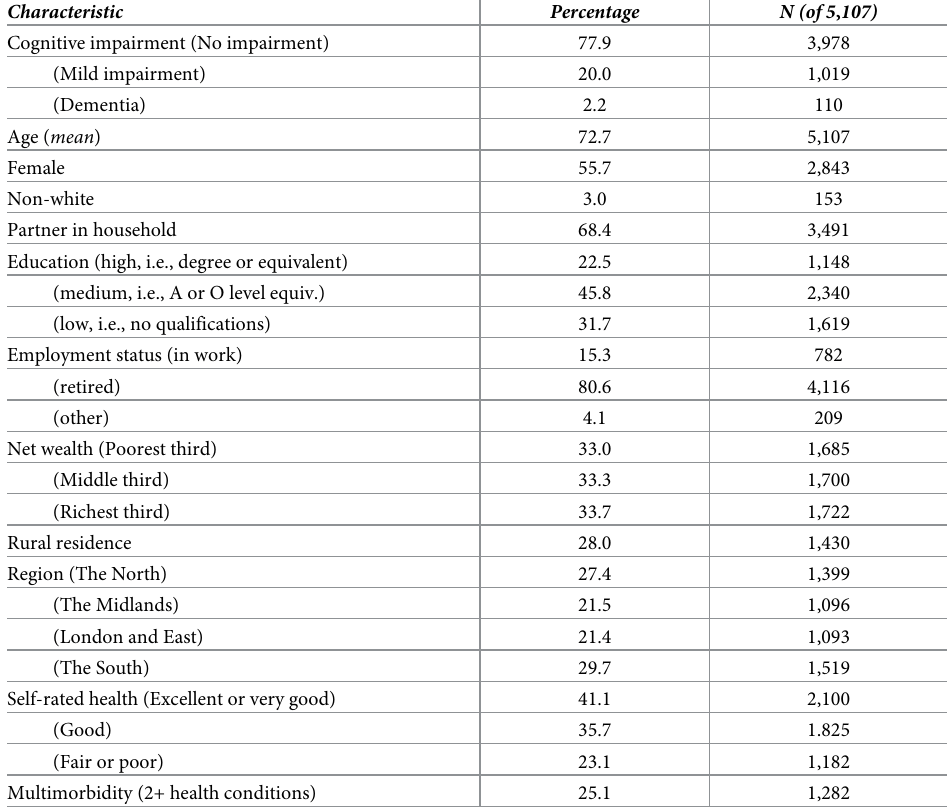
Table 1. Sociodemographic characteristics among the sample for depression at the first assessment of the ELSA COVID-19 sub-study (June/July 2020). Characteristic Percentage